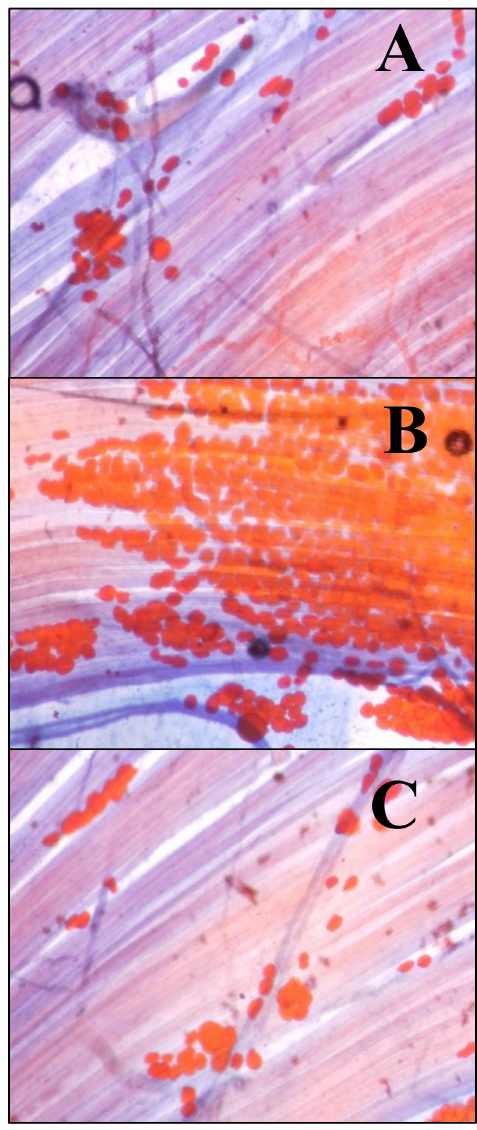
Figure 2. Intramuscular adipocytes. The adipocytes were stained with Sudan III. Fat looks orange. Methylene blue has been used as a contrast dye. ( A ) Levator auris longus (LAL) muscle from a control animal. ( B ) LAL muscle from an animal exposed to a cafeteria diet for 6 weeks. ( C ) LAL muscle from an animal exposed to a high-fat diet for 6 weeks. Initial magnification 400 ×